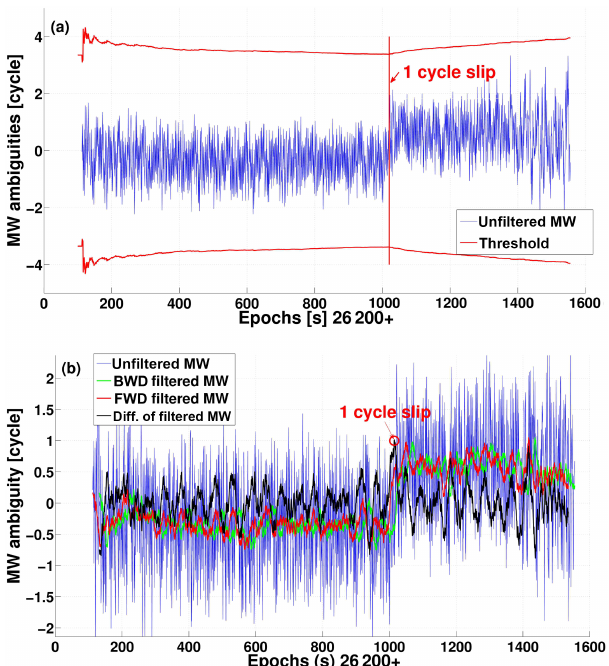
Figure 6. Illustration of the proposed cycle-slip detection approach based on Melbourne–Wübbena combination, PRN23 of Swarm A on DoY 333, 2015: (a) TurboEdit method, the cycle slip cannot be detected; (b) FBMWA (forward and backward moving window averaging) method (cid:49)b 1 − (cid:49)b 2 =